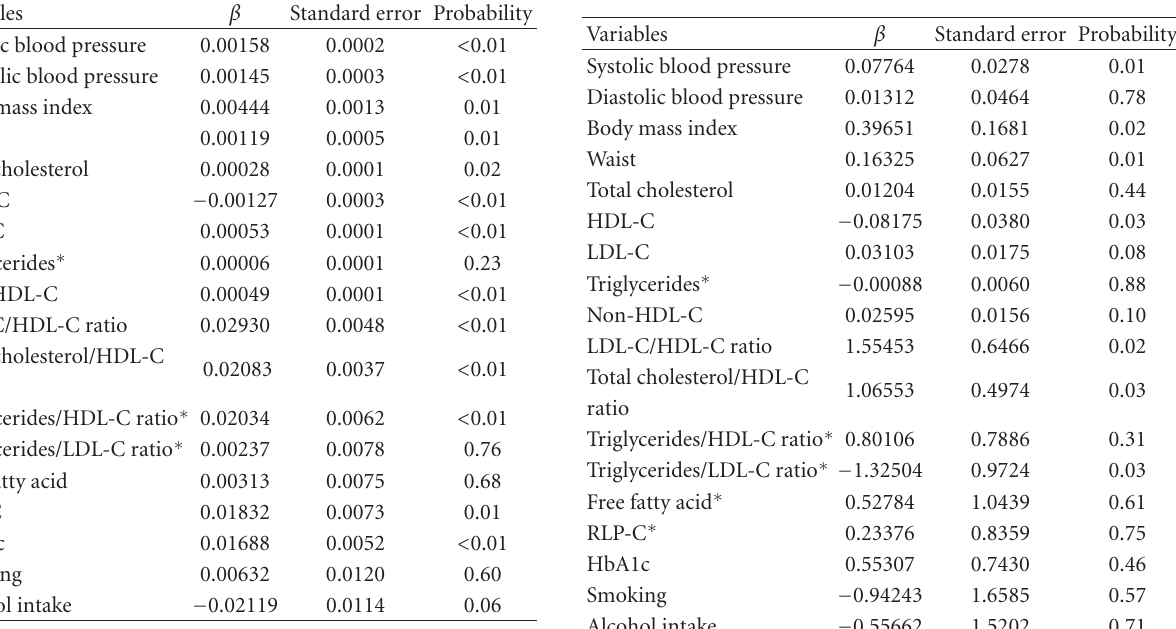
Table 3: Relationship between 8-year changes in IMT and variables in multiple linear regression analysis adjusted for age, sex, and baseline